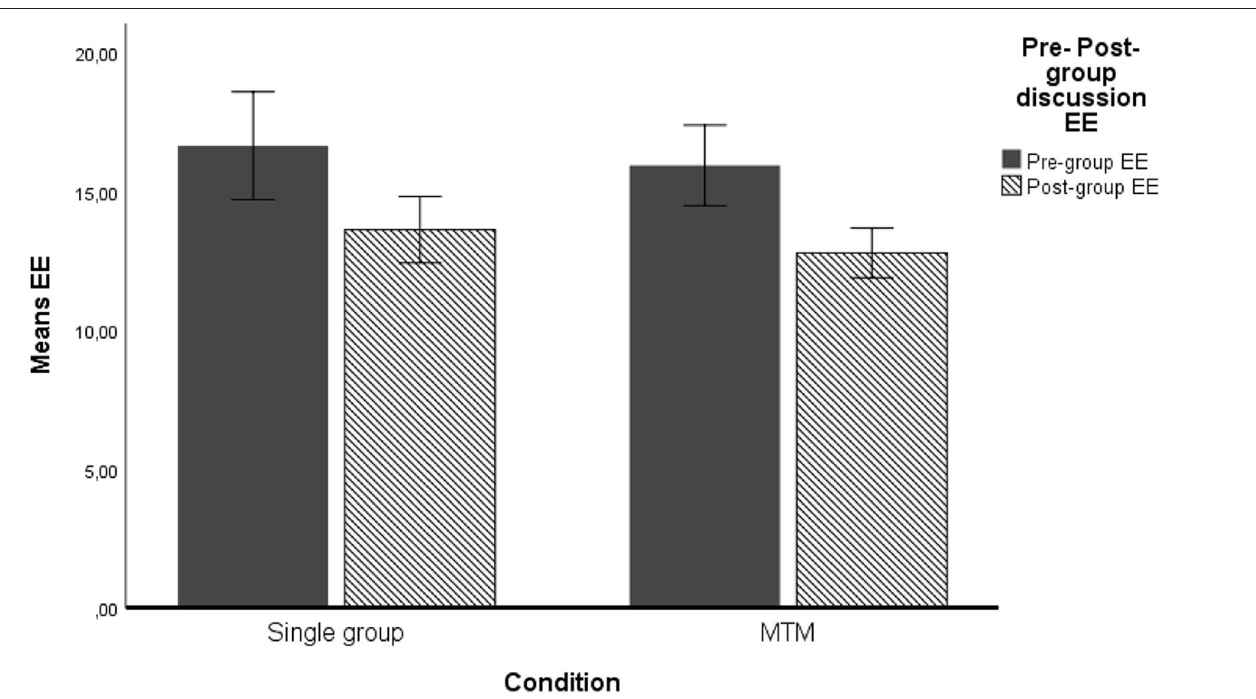
FIGURE 2 | Means estimation error (EE) pre- and post-group discussion. Covariates appearing in the model are evaluated at the following values: Age = 20.7925. NFC = 3.5736. AVGErrGR = 12.0316. Error bars: 95% CI.